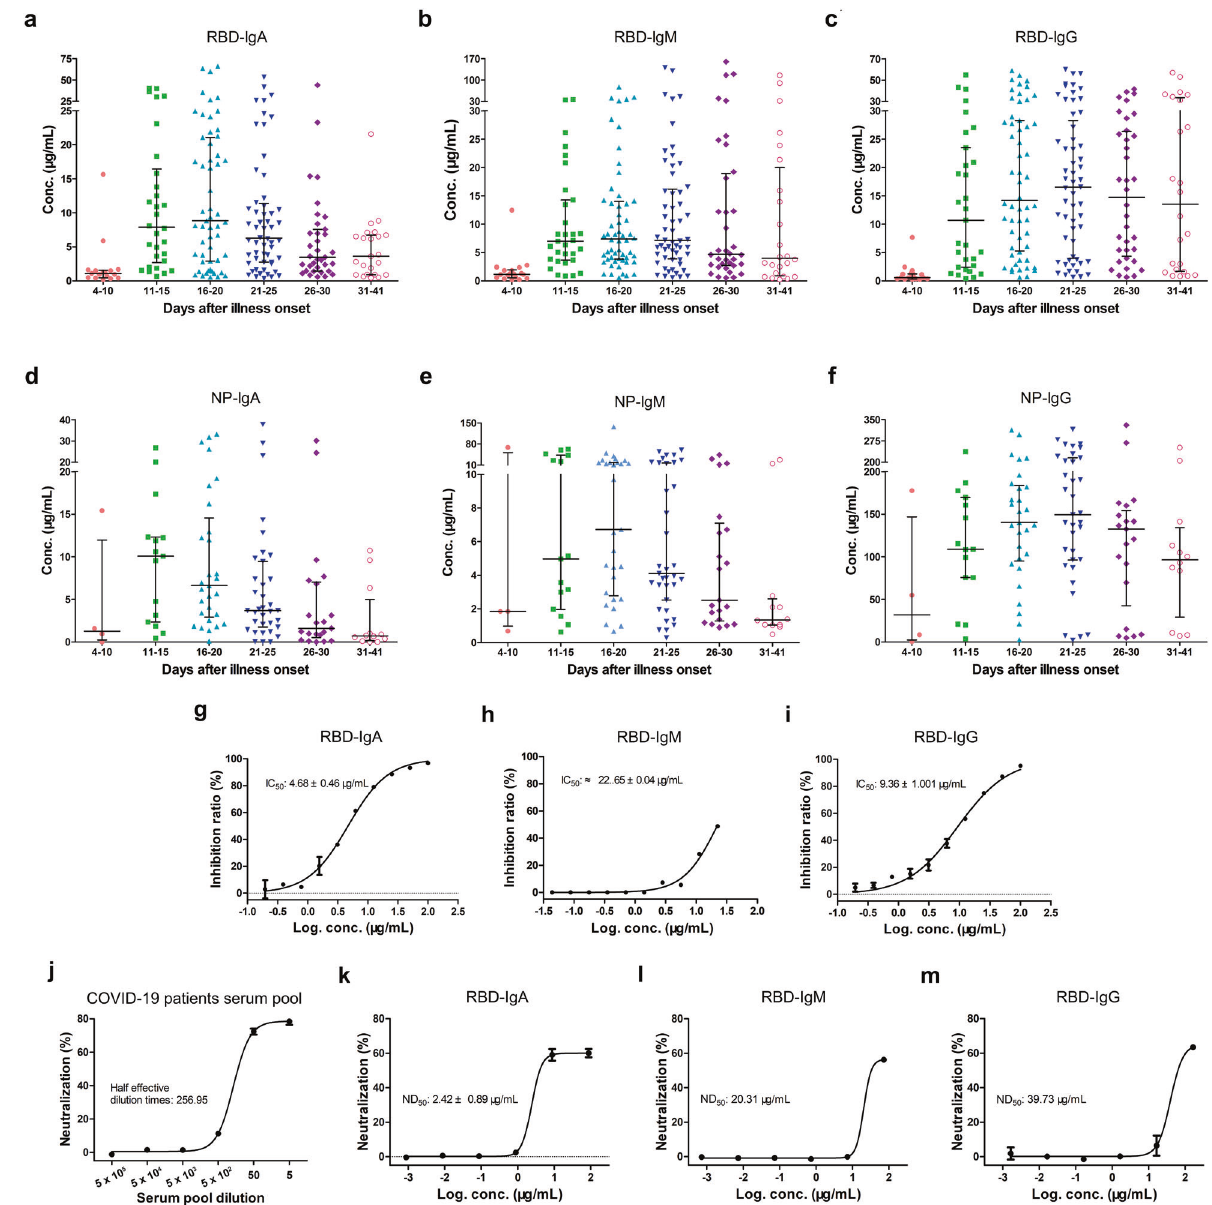
Fig. 1 Characterization of serum IgA, IgM, and IgG in COVID-19 patients. a – c The kinetics of RBD-speci fi c IgA ( a ), IgM ( b ), and IgG ( c ) levels in sera of COVID-19 patients at different time windows. d – f The kinetics of NP-speci fi c IgA ( d ), IgM ( e ), and IgG ( f ) levels in sera of COVID-19 patients at different time windows. The median values of RLU or calculated antibody mass concentrations were plotted for each isotype of three antibodies. Bars indicate interquartile ranges. g , h The ef fi ciency of RBD-IgA ( g ), IgM ( h ), and IgG ( i ) competing with hACE2 in binding SARS-CoV-2 RBD were determined by ELISA. The IC 50 was measured by GraphPad Prism 5.0. j – m COVID-19 convalescent patients ’ serum pool ( j ) and RBD-speci fi c IgA ( k )/IgM ( l )/IgG ( m )-mediated neutralization of SARS-CoV-2 infection in Vero-E6 cells. The ND 50 were fi tted by GraphPad Prism